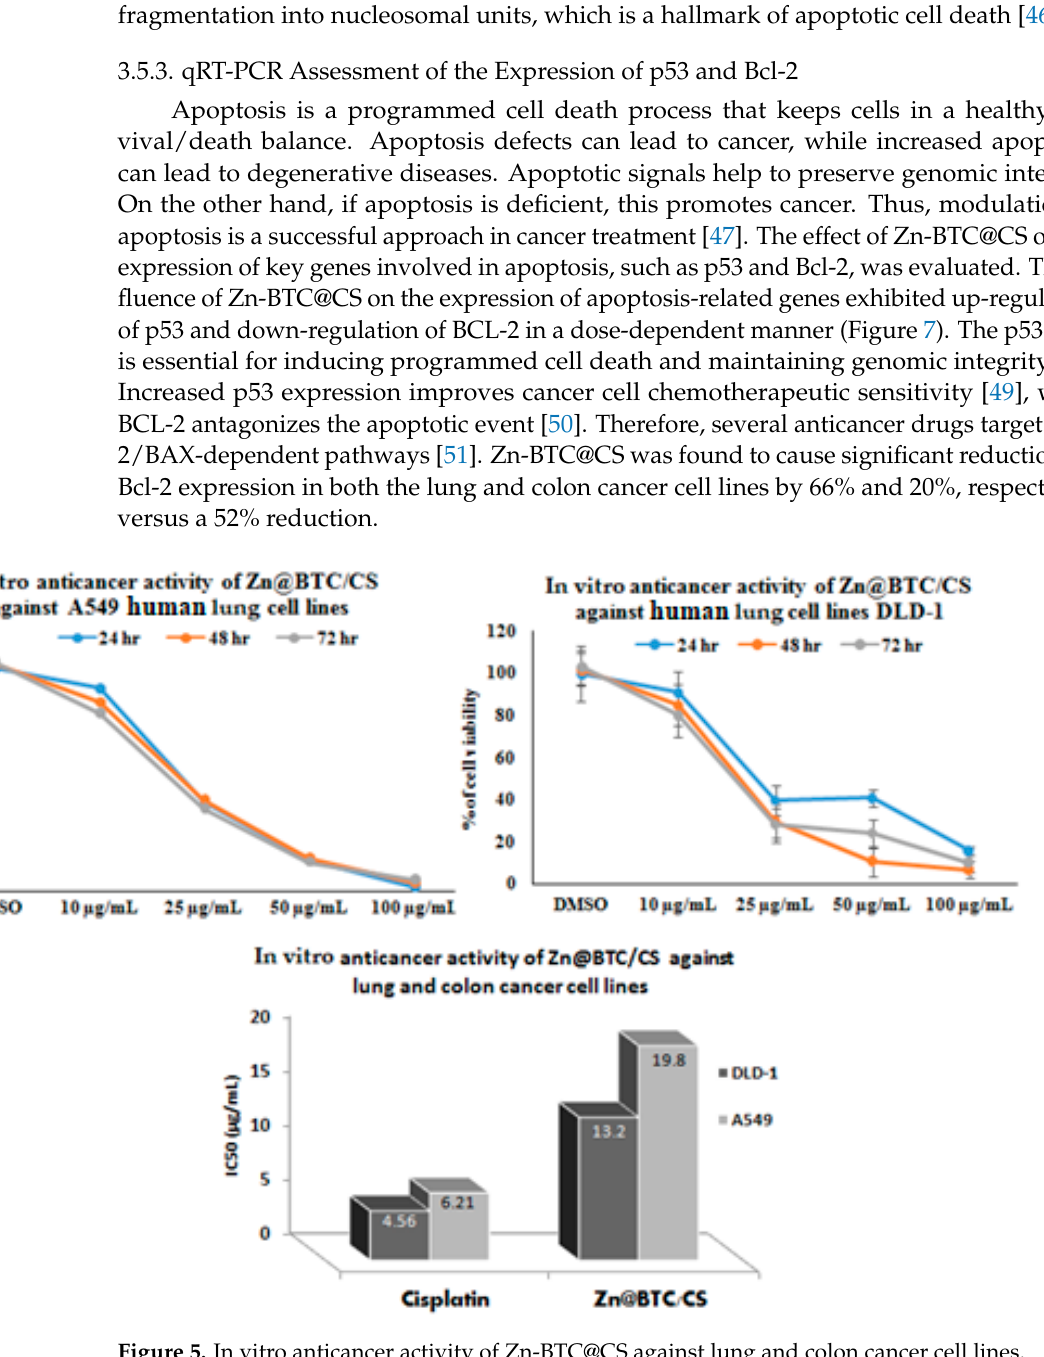
Figure 5. In vitro anticancer activity of Zn-BTC@CS against lung and colon cancer cell lines.